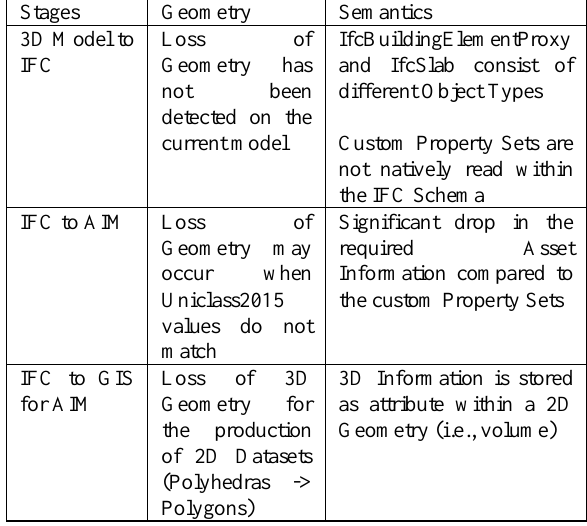
Figure 4 . Object Types per IFC Class.